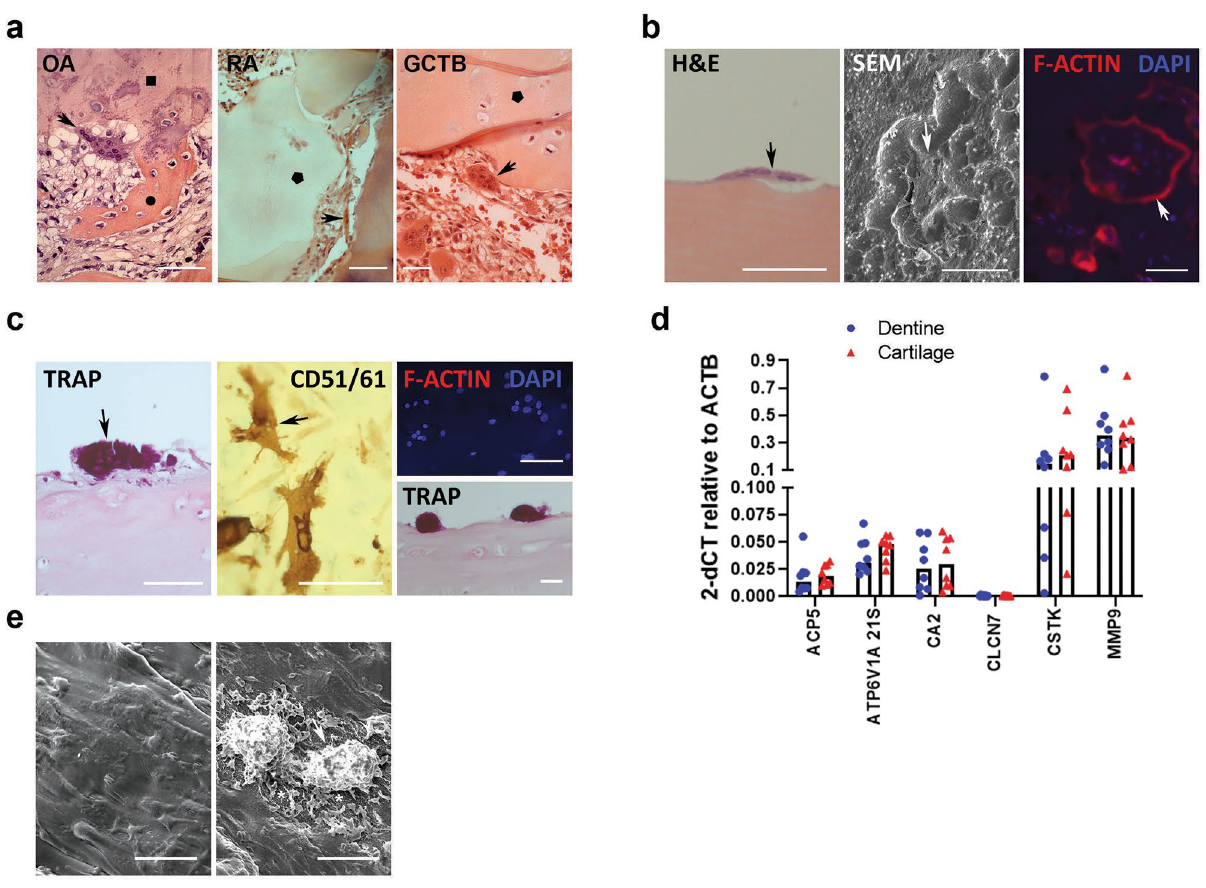
Figure 1. Osteoclasts visibly degrade cartilage matrix. ( a ) H&E staining of OA knee, RA and GCTB tissue. Multi-nucleated osteoclasts (arrow) resorb subchondral bone ( ) and invade mineralised ( ) and unmineralised cartilage ( ). ( b ) Osteoclasts (arrow) differentiated on dentine with (left) H&E-stained transverse section showing visible subcellular resorption, (middle) SEM image of a 97.49 µm diameter osteoclast surrounded by resorption tracks, and (right) F-actin rings (red) around multi-nucleated (blue) osteoclast. ( c ) Osteoclasts (arrow) differentiated on acellular cartilage showing (left, bottom right) TRAP-stained transverse section through multi-nucleated osteoclasts with no visible subcellular resorption and (middle) CD51/61- positive osteoclasts with (top right) no evidence of F-actin ring formation. ( d ) Expression of classical osteoclast marker genes by osteoclasts differentiated on dentine or acellular cartilage. ACP5 = TRAP , CLCN7 = H + / Cl − transporter channel 7), CTSK = cathepsin K (n = 8; multiple Mann–Whitney). ( e ) SEM images of (left) acellular cartilage and (right) osteoclasts (arrow) on acellular cartilage showing visible degradation the surrounding cartilage matrix (*). All scale bars = 100